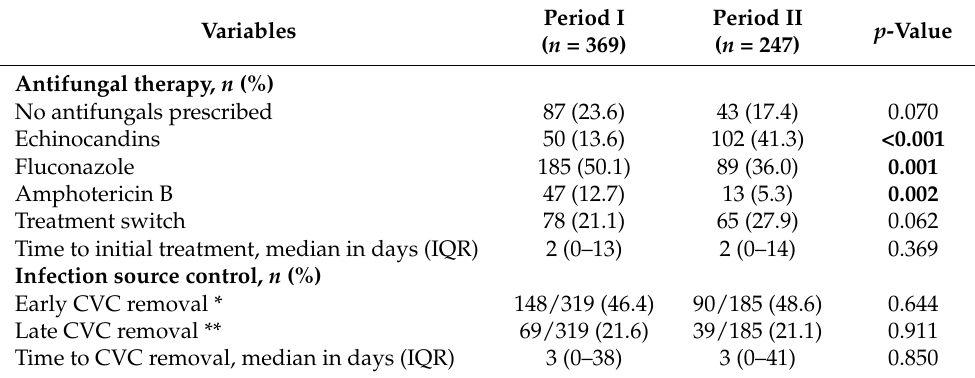
Table 3. Overall therapeutic management of 616 adults with candidemia diagnosed at tertiary